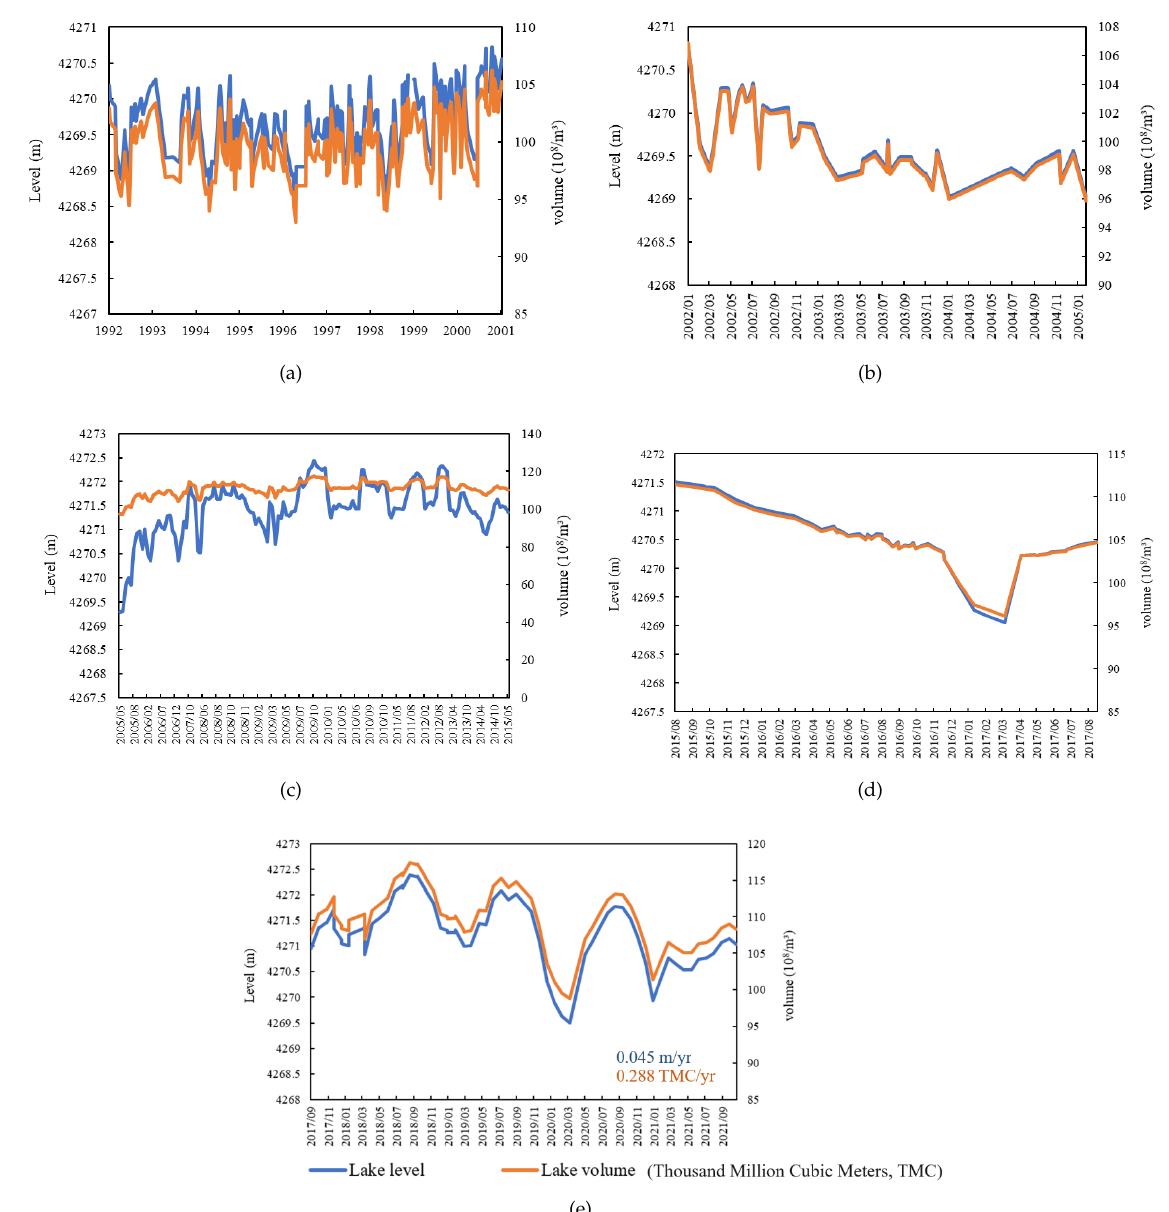
Figure 7. Fluctuation of the water level (blue lines) and water storage capacity (orange lines) of Ngoring Lake in different years. ( a ) Changes in the water level and volume of Ngoring Lake from 1992 to 2001; ( b ) Changes in the water level and volume of Ngoring Lake from 2002 to 2005; ( c ) Changes in the water level and volume of Ngoring Lake from 2005 to 2015; ( d ) Changes in the water level and volume of Ngoring Lake from 2015 to 2017; ( e ) Changes in the water level and volume of Ngoring Lake from 2017 to